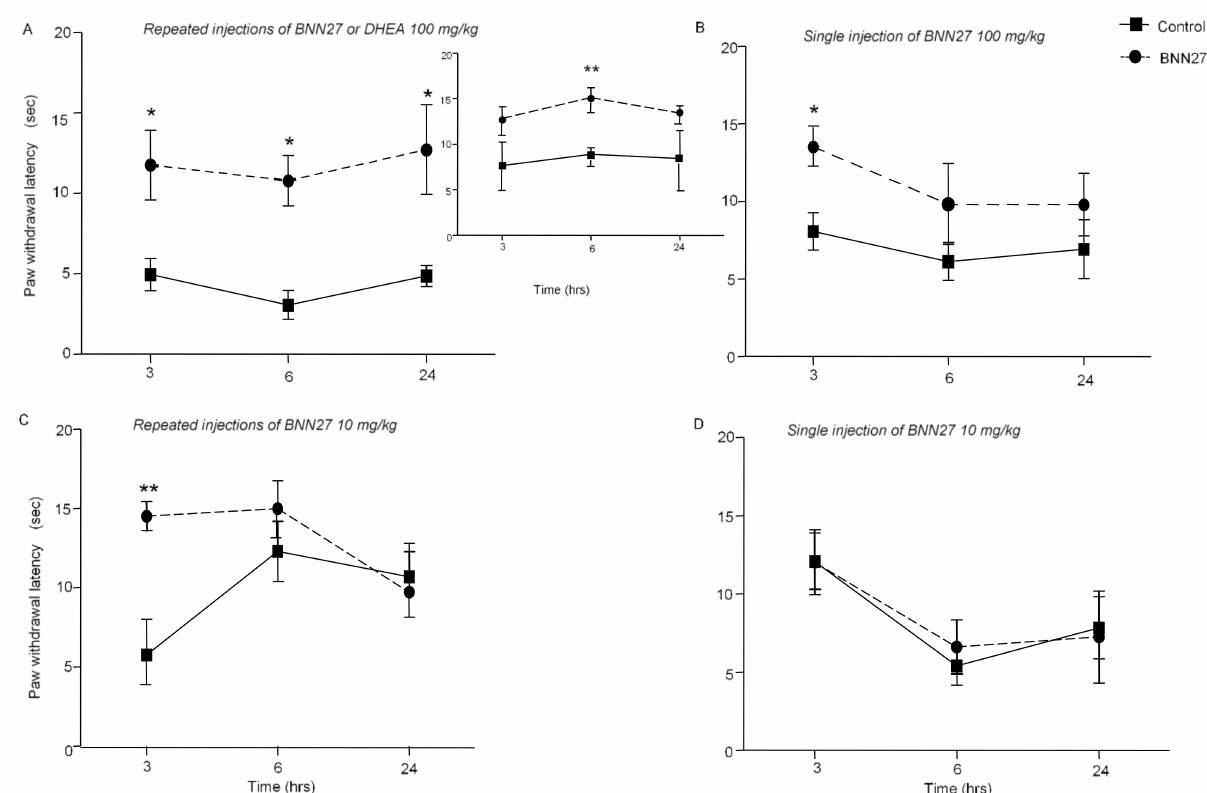
Figure 2. Treatment with BNN27 reduced hyperalgesia in mice at different times and doses examined. ( A ) Repeated injections of 100 mg/kg BNN27 or DHEA (insert graph), following injection of CFA, increased the hyperalgesia threshold. ( B ) Single administration of 100 mg/kg BNN27 was effective 3 h following the induction of the inflammation. ( C ) Repeated injections of 10 mg/kg BNN27 increased paw withdrawal latency, 3 h following the induction of inflammation; however, the same dose was ineffective when administered as a single dose ( D ). ( A ) BNN27 graph: Control n = 5 mice, BNN27-treated group n = 5 mice; DHEA graph: Control n = 4 mice, DHEA-treated group n = 4 mice; ( B ) Control n = 8 mice, BNN27-treated group n = 10 mice; ( C ) Control n = 3 mice, BNN27-treated group n = 4 mice; ( D ) Control n = 3 mice, BNN27-treated group n = 4 mice. In all panels, * p < 0.05, ** p < 0.01. Statistical analysis was performed using 2-way ANOVA following LSD post-hoc tests. All data are expressed as the mean ±